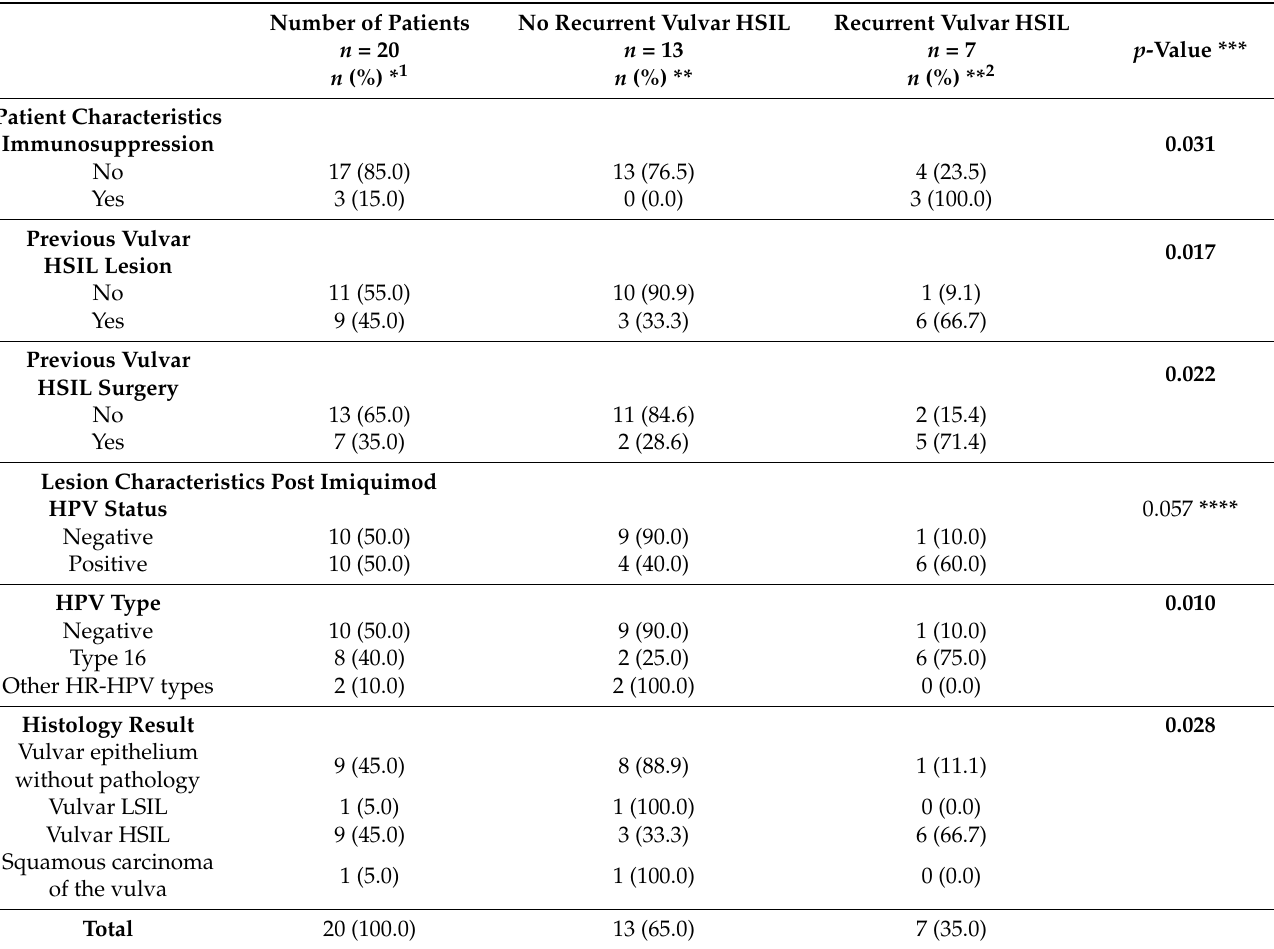
Table 8. Recurrent vulvar high-grade squamous intraepithelial lesion (vulvar HSIL) after treatment with imiquimod in patients with vulvar